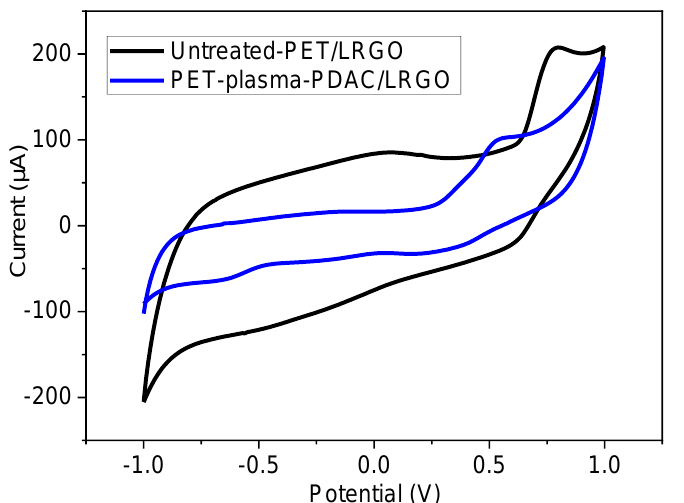
Figure 7. Current and oxidation potential peak (Epa) for nitrite oxidation performed with untreated- PET/LRGO and PET-plasma-PDAC/LRGO during 5 successive cyclic voltametric runs.